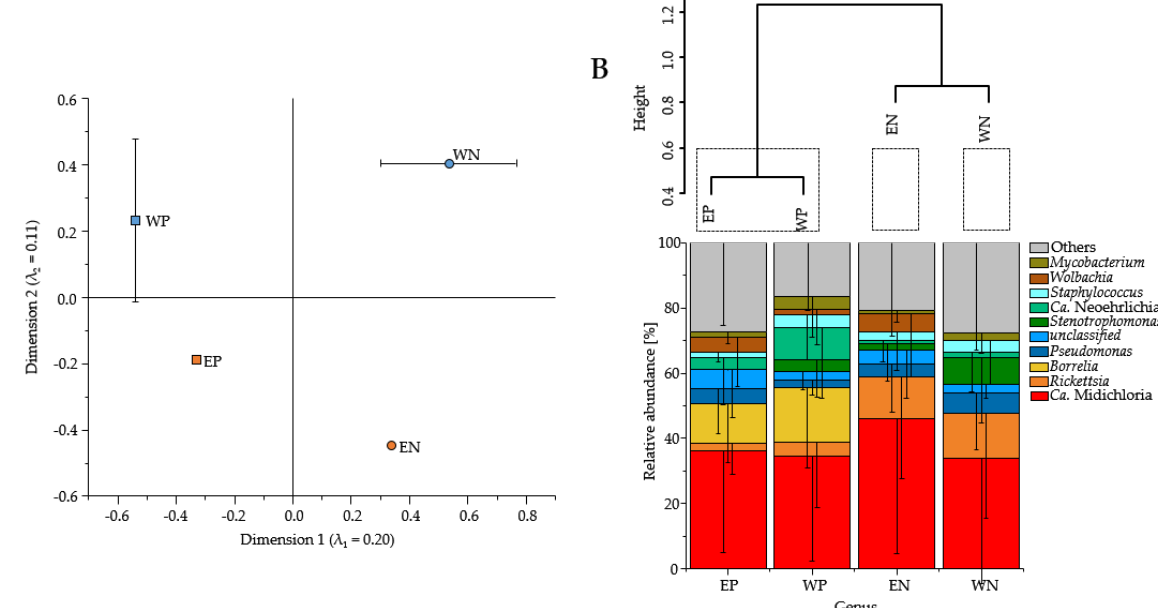
Figure 1. Correspondence analysis of bacterial community compositions ( A ), Euclidean distance matrix based on ward.D2 method (B above), and bacterial community composition (( B ) below) of Borrelia -negative ticks retrieved from Esslingen (EN; n = 62; orange circle) or Weiden (WN; n = 56, blue circle) and Borrelia -positive ticks retrieved from Esslingen (EP; n = 38; orange square) or Weiden (WP; n = 44; blue square). Bacterial community composition is based on genus level with relative abundance data. The eigenvalues of both axes and standard errors are shown ( A ). For clusters, heights of 0.6 were chosen and denoted in dashed boxes (( B ) above). Bacterial community composition of the ten most abundant genera are shown, and other genera are summarized as “others”. For colors and patterns, see figure legend.